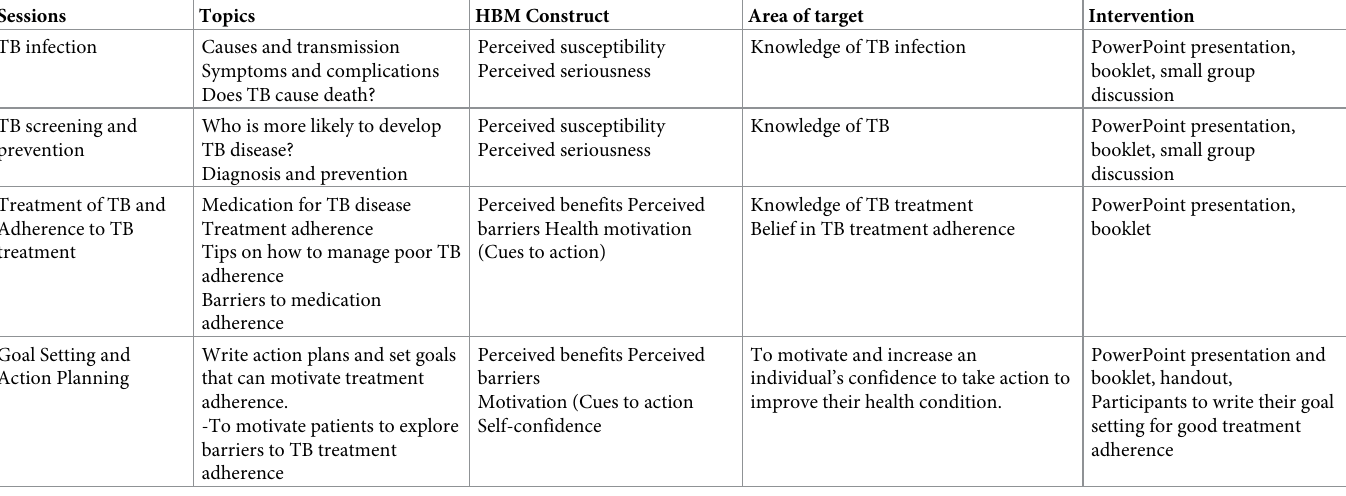
Table 1. Overview of the educational intervention on TB treatment